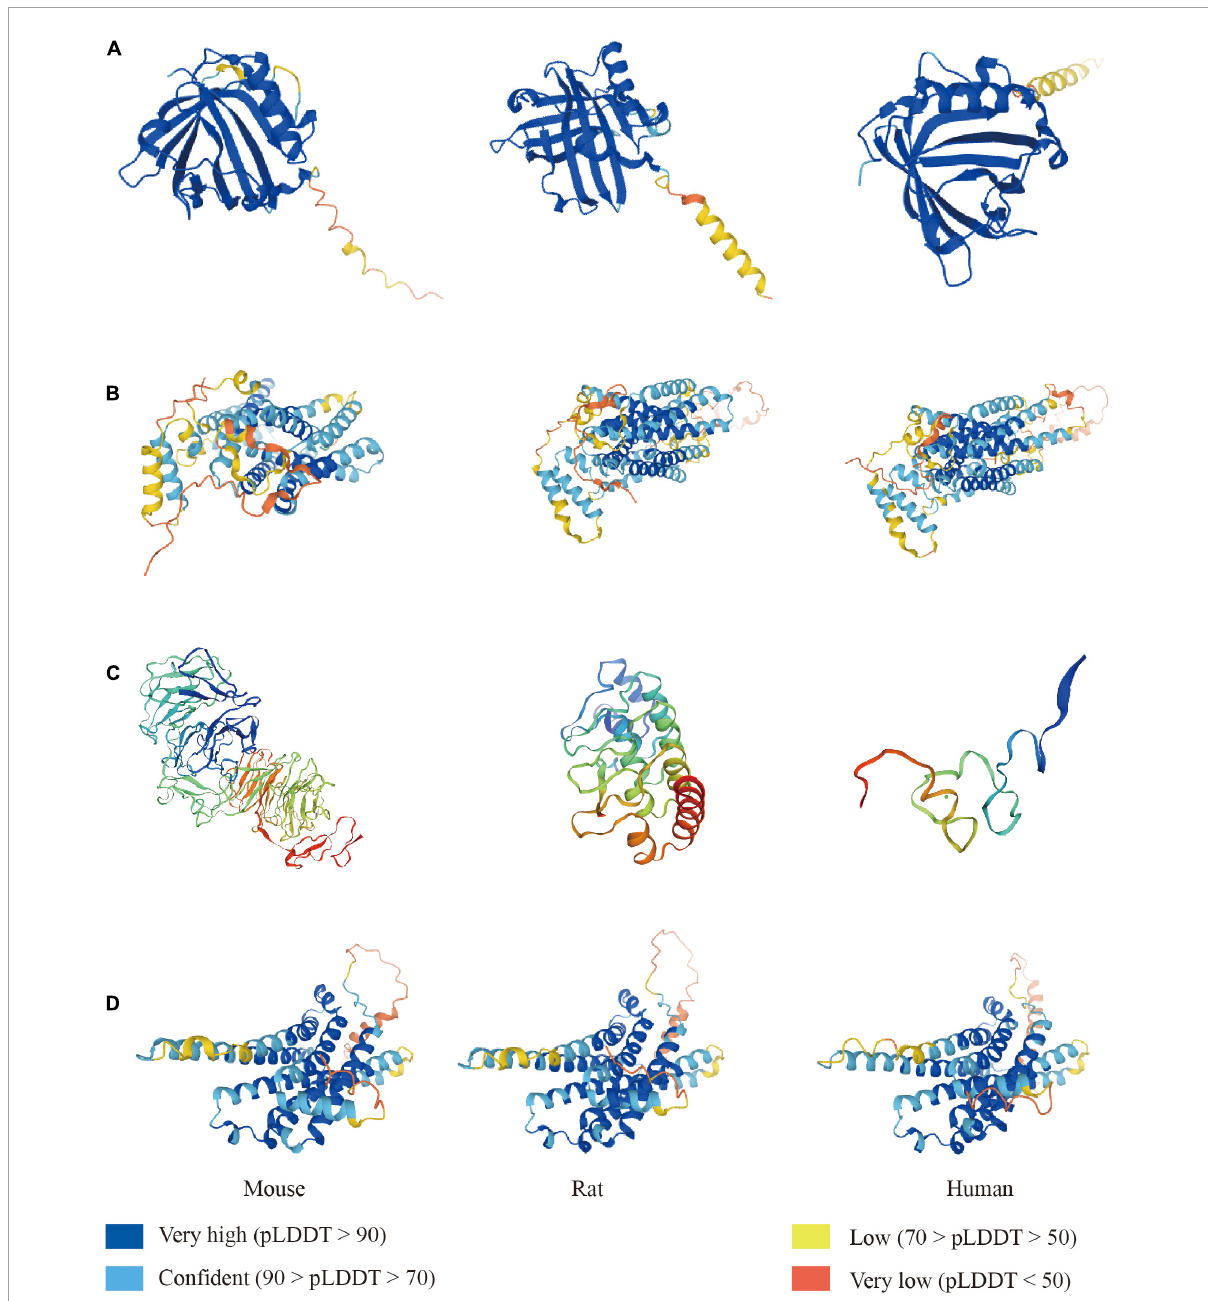
FIGURE1 The LCN2 and its receptors fold in mouse, rat, and human. Construction of LCN2 (A) and 24p3R (B) predicted from the alphafold protein structure database. Construction of megalin (C) predicted from the Swiss-model database. Construction of MC4R (D) predicted from the alphafold protein structure